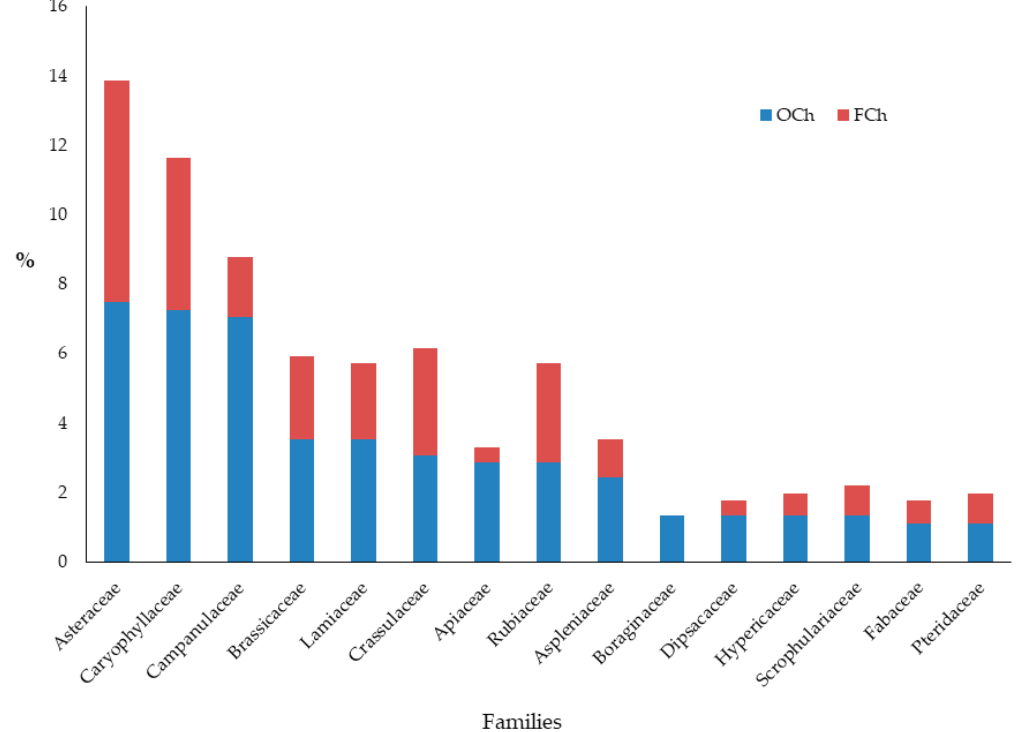
Figure 2. Richest in taxa families of the Aegean chasmophytic flora. Each bar represents the % representation of each family in the total chasmophytic flora as composed by the proportion of the representation of OCh (obligate chasmophytes) plus FCh (facultative chasmophytes).